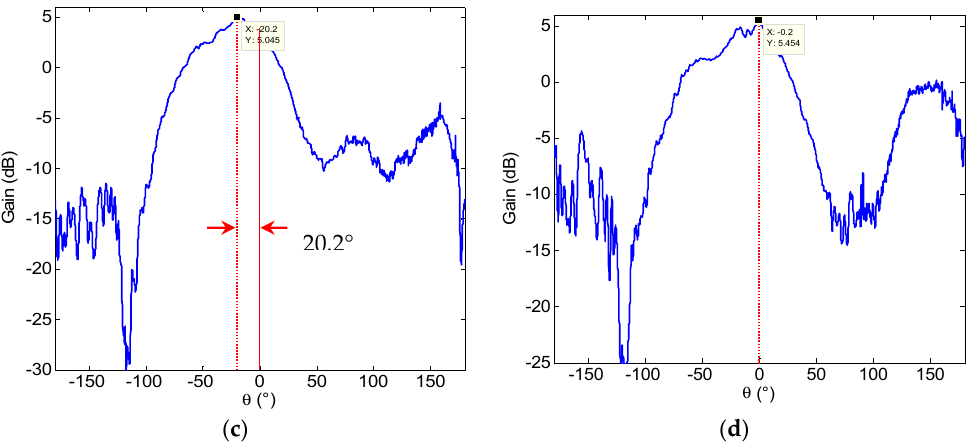
Figure 8. The measured pattern of the proposed antenna using RF MEMS switches. ( a ) In the (0,0) state. ( b ) In the (0,1) state. ( c ) In the (1,0) state. ( d ) In the (1,1) state.